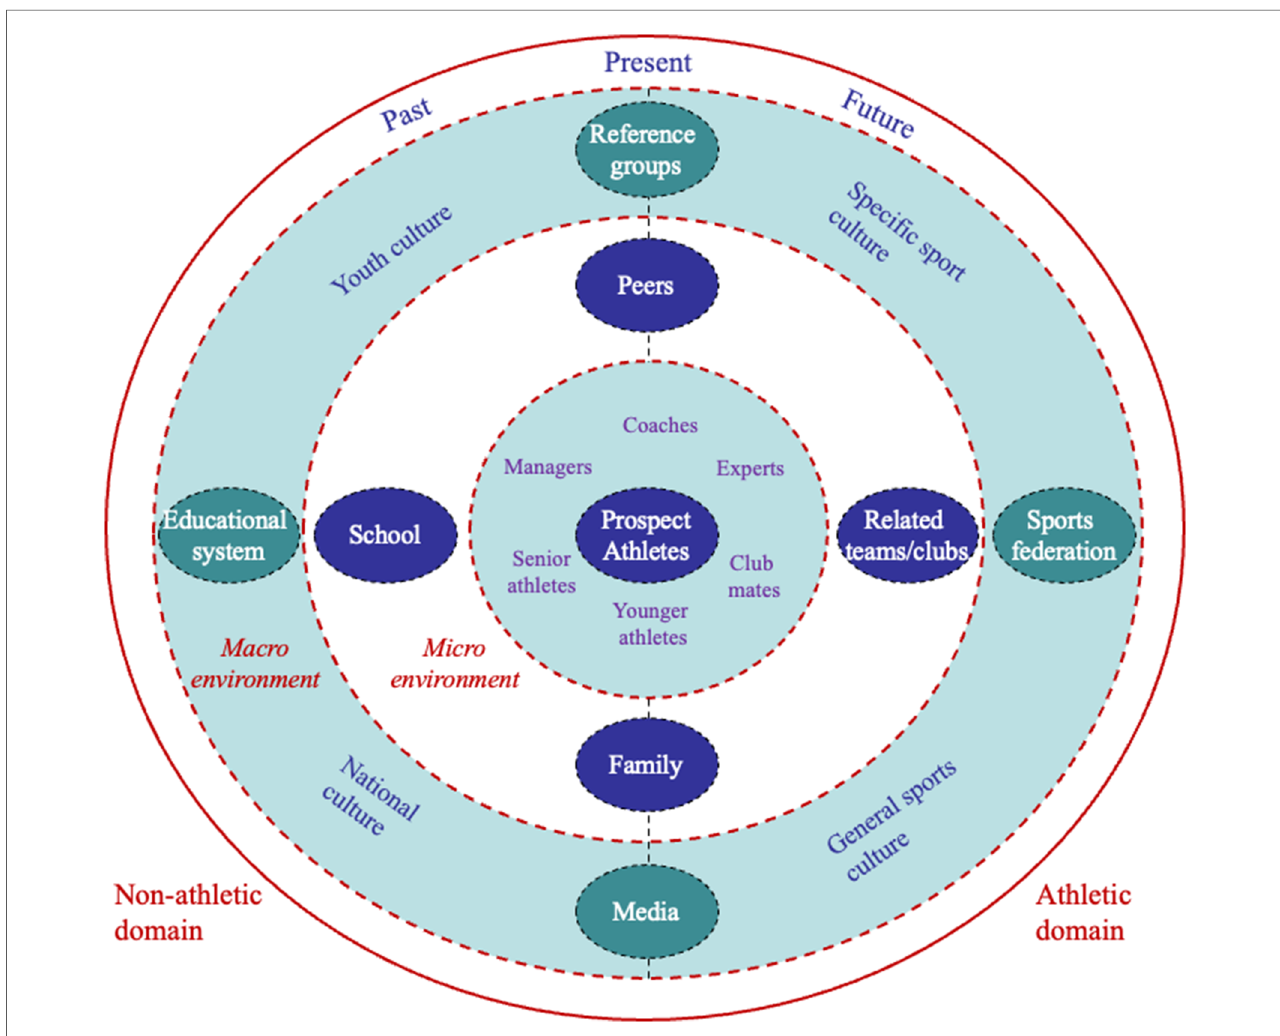
FIGURE 1 The athletic talent development environment (ATDE) working model. Reprinted with